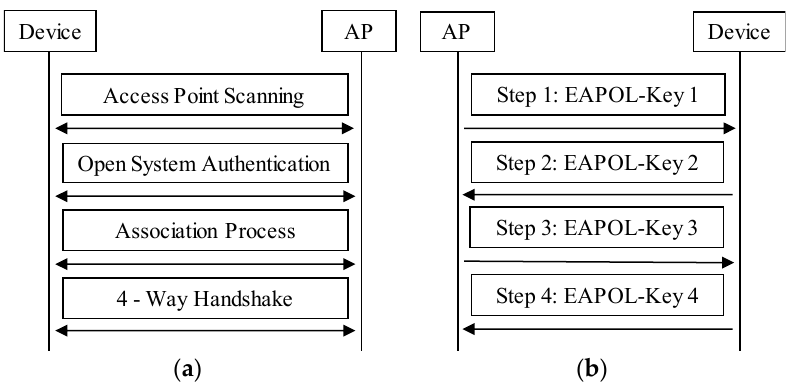
Figure 3. Procedures of accessing an encrypted AP. ( a ) Access procedures; ( b ) The 4-way handshake.